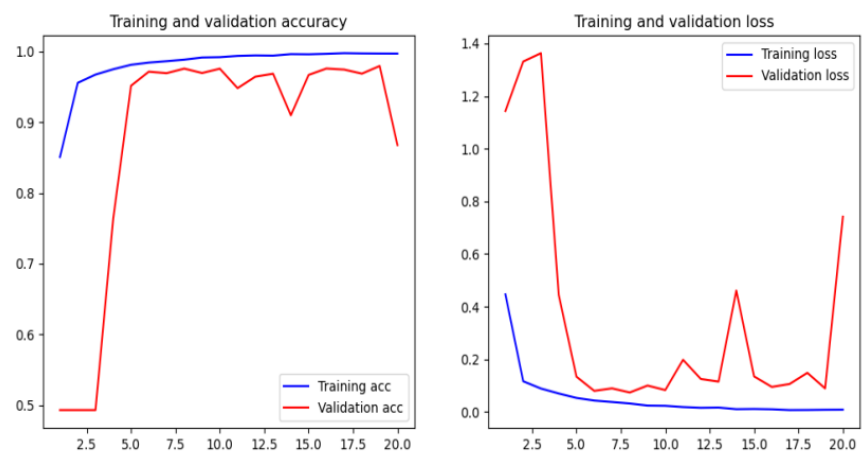
Figure 17. Evaluation of very deep convolutional neural network (VDCNN) model on D2 using